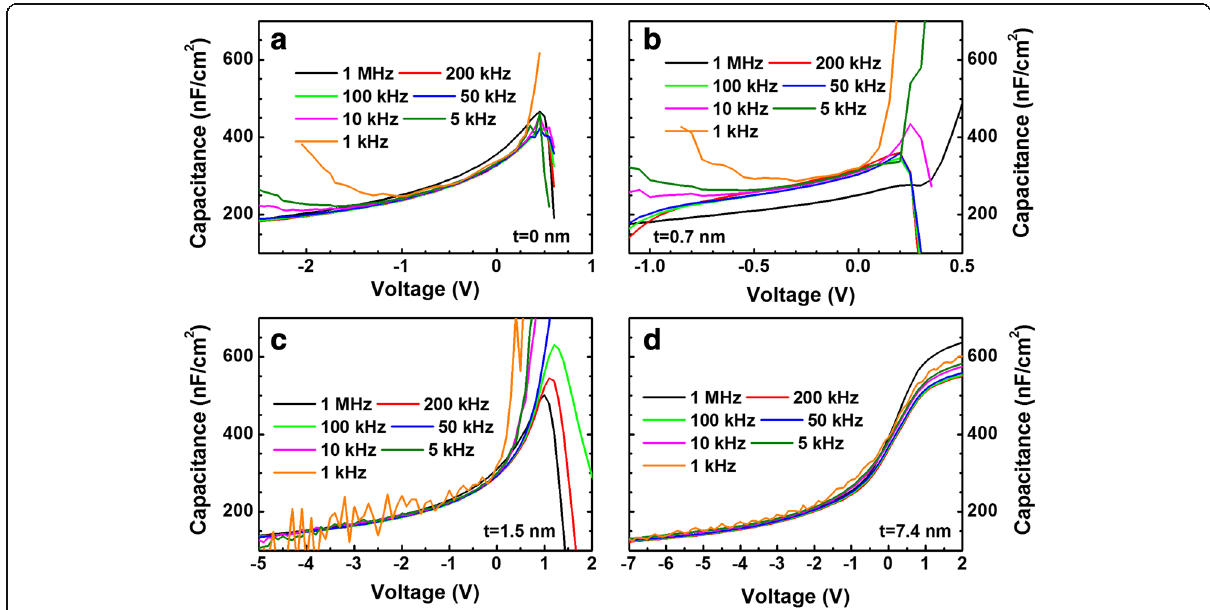
Fig. 3 Capacitance – voltage ( C – V ) data measured at various frequencies for the samples with a 0-, b 0.7-, c 1.5-, and d 7.4-nm-thick